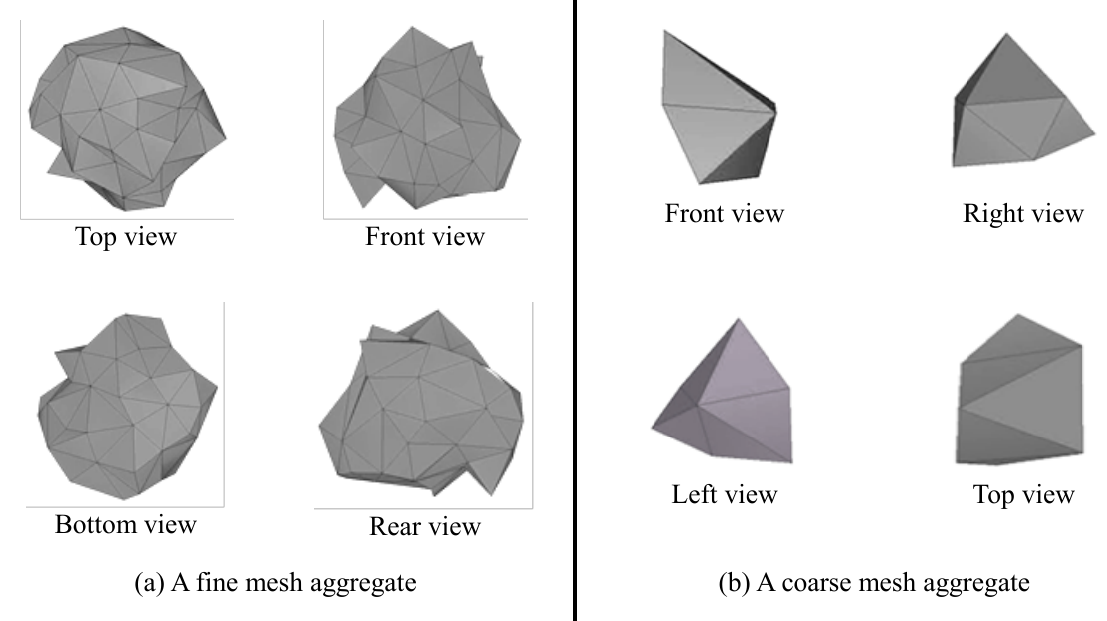
Fig. 8. Typical irregular stone geometry views using fine and coarse